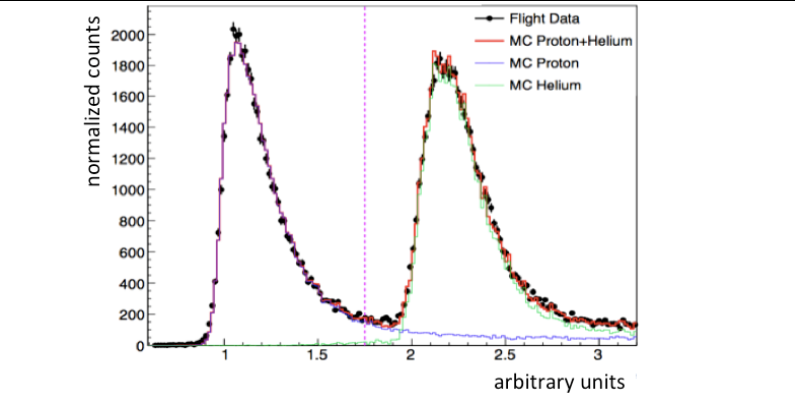
Figure 5. Combined PSD signal for protons and helium nuclei, for BGO energies in the range from 447 GeV to 562 GeV. The color codes to distinguish on-orbit and simulated data are shown in the plot. The cut to select proton candidates is represented by the vertical dotted line.